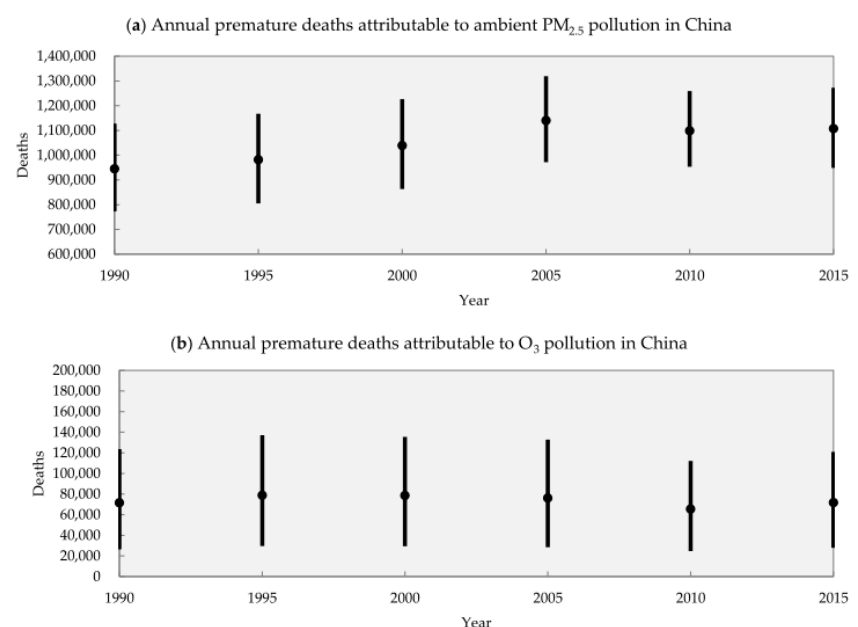
Figure 3. China’s annual premature deaths attributable to PM 2.5 ( a ) and O 3 ( b ), 1990–2015. Dots show the estimated base value, bars show lower and upper bound of estimates. Based on data in the Global Burden of Disease Study 2015 [37]. Note the different scales of the vertical axes in ( a , b ).